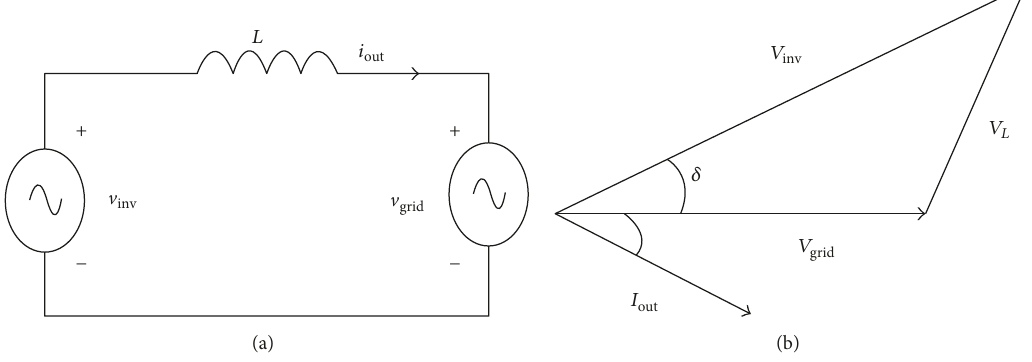
Figure 1: Grid connected inverter: (a) equivalent circuit and (b) phasor